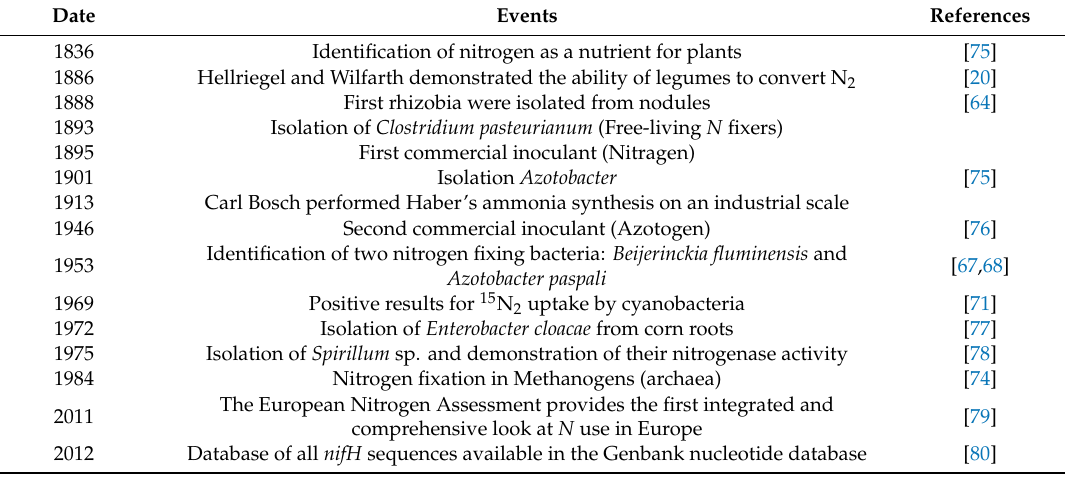
Table 1. Some key dates of history of research on nitrogen, biological nitrogen fixation (BNF), and biofertilizers.